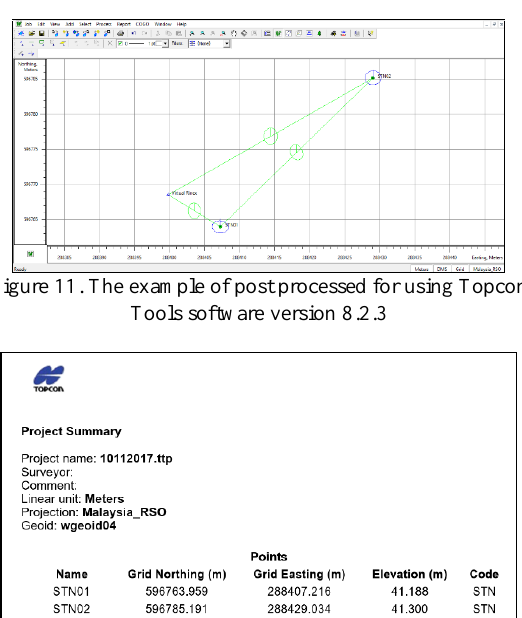
coordinate value between both epochs.